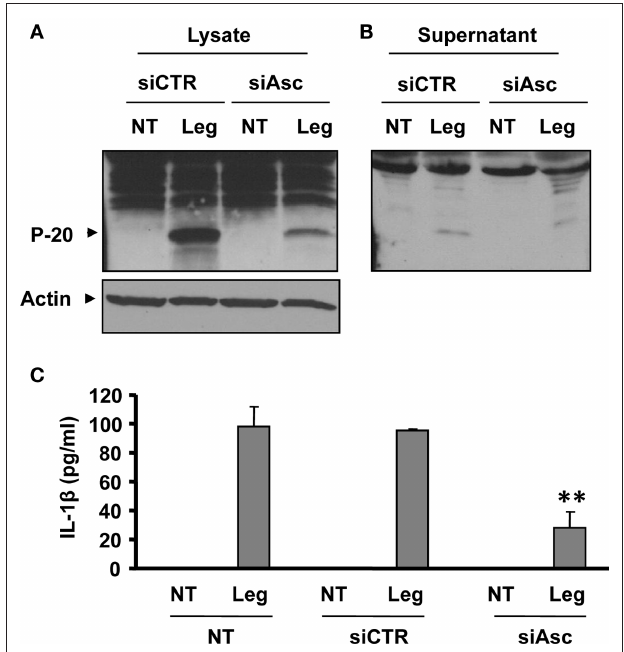
Figure 4 | Depletion of Asc decreases caspase-1 activation in response to L. pneumophila infection. (A,B,C) WT mouse macrophages were transfected or not (NT) with Asc specific siRNA (siAsc) or control siRNA (siCtr) and 48 h after transfection cells were infected with L. pneumophila (Leg). Then, active caspase-1 (p-20) was detected in the cell extracts (A) and in the supernatants (B) of 8 h infected samples by Western blotting. Active IL-1 β was detected in supernatants using ELISA (C) . The results displayed as mean ± SD (** P ≤ 0.01) of three independent